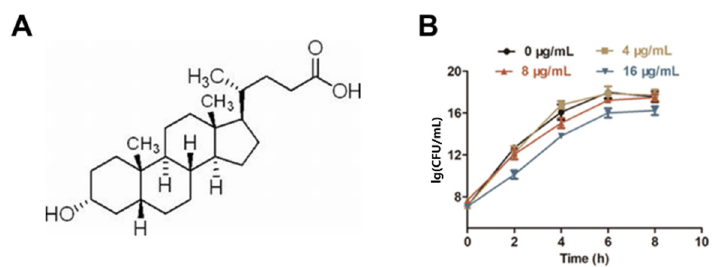
Figure 1. LCA had no influence on the growth of L. monocytogenes at a concentration of less than 16 µ g/mL. ( A ) Chemical structure of LCA. ( B ) Growth curve of L. monocytogenes cultured in TSB containing the indicated concentrations of LCA.